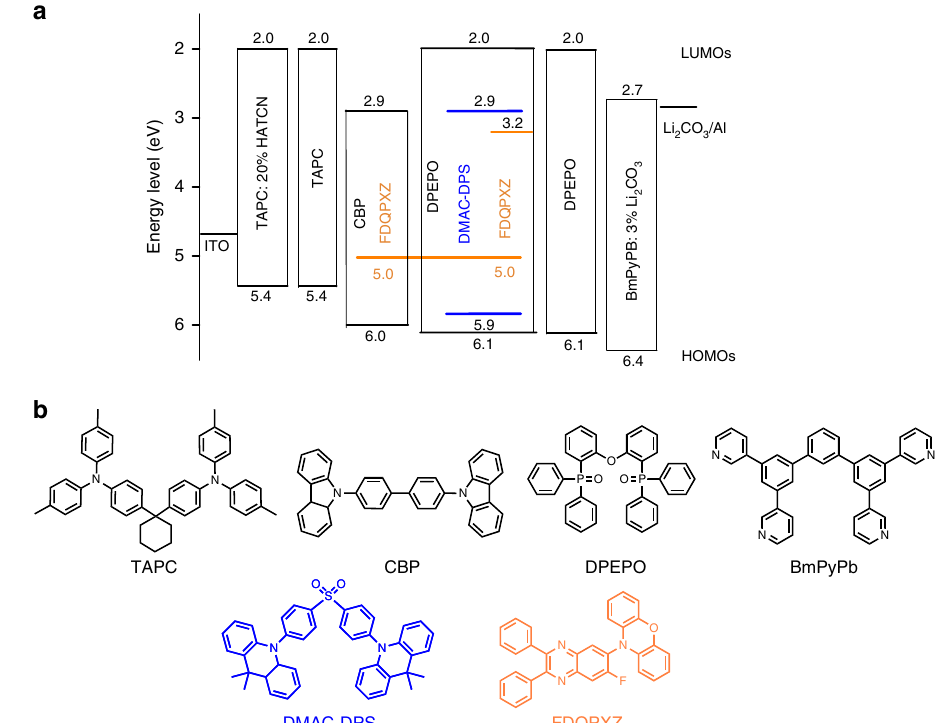
Fig. 1 Energy-level diagram and chemical molecular structures. a Proposed energy-level diagram of the fl uorescent white organic light-emitting diodes (WOLEDs). Note that these numbers indicate the respective highest occupied and lowest unoccupied molecular orbital (HOMO and LUMO, respectively) energies relative to the vacuum level. b Chemical molecular structures of the functional materials